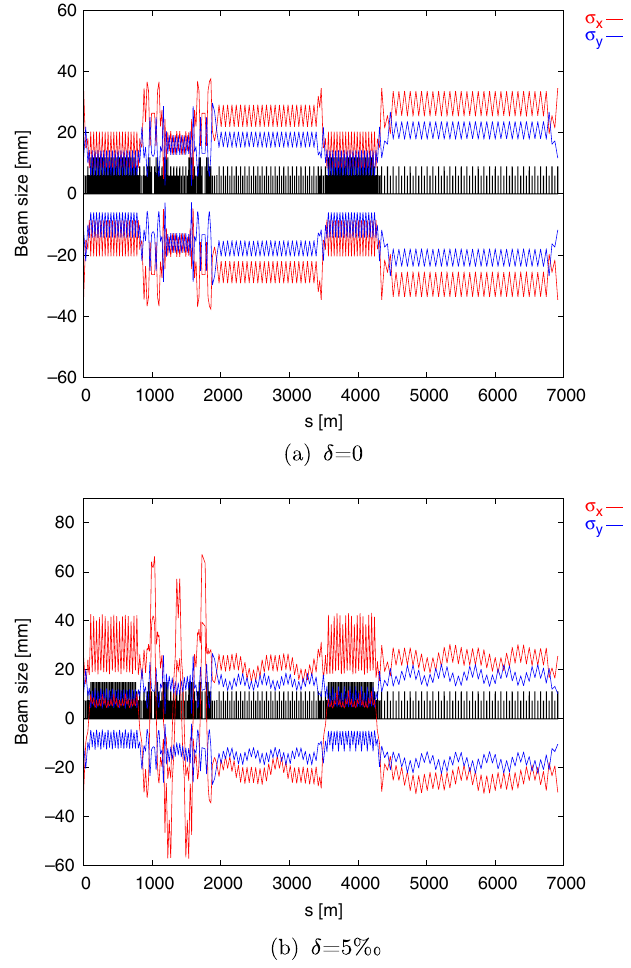
FIG. 37. Beam sizes at 6 σ and 5 σ in the decay ring respectively at the reference (top) and injection energy (bottom).